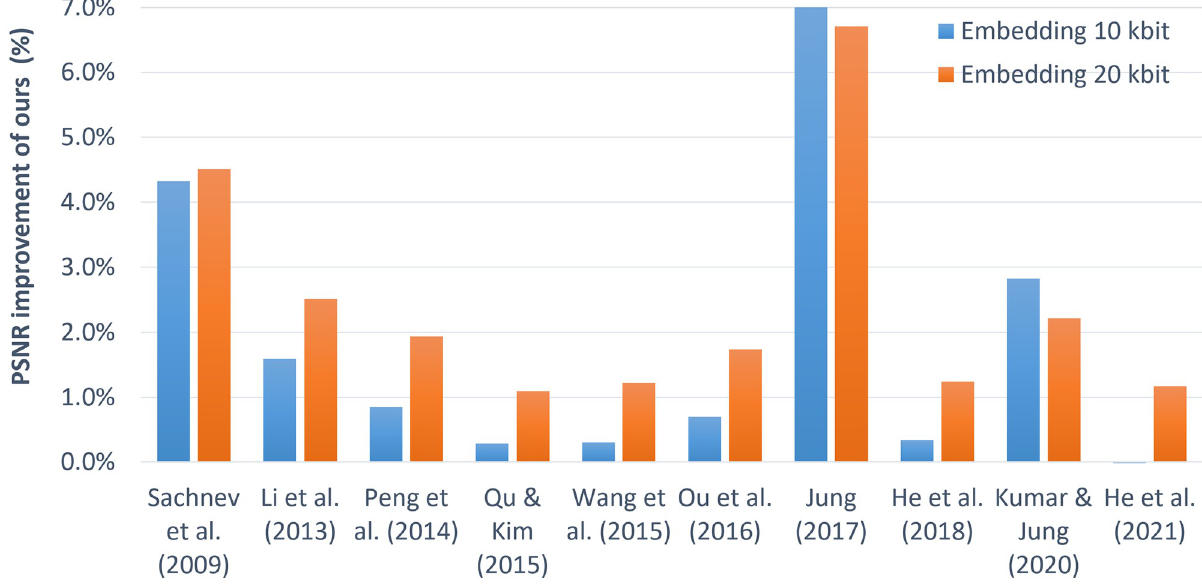
Fig 7. Average improvement for embedding 10 kbit and 20 kbit over the schemes: He et al . (2021) [54], Kumar & Jung (2020) [53], He et al . (2018) [38], Jung (2017) [36], Ou et al . (2016) [34], Wang et al . (2015) [33], Qu & Kim (2015) [32], Peng et al . (2014) [30] and Sachnev et al . (2009) [19].